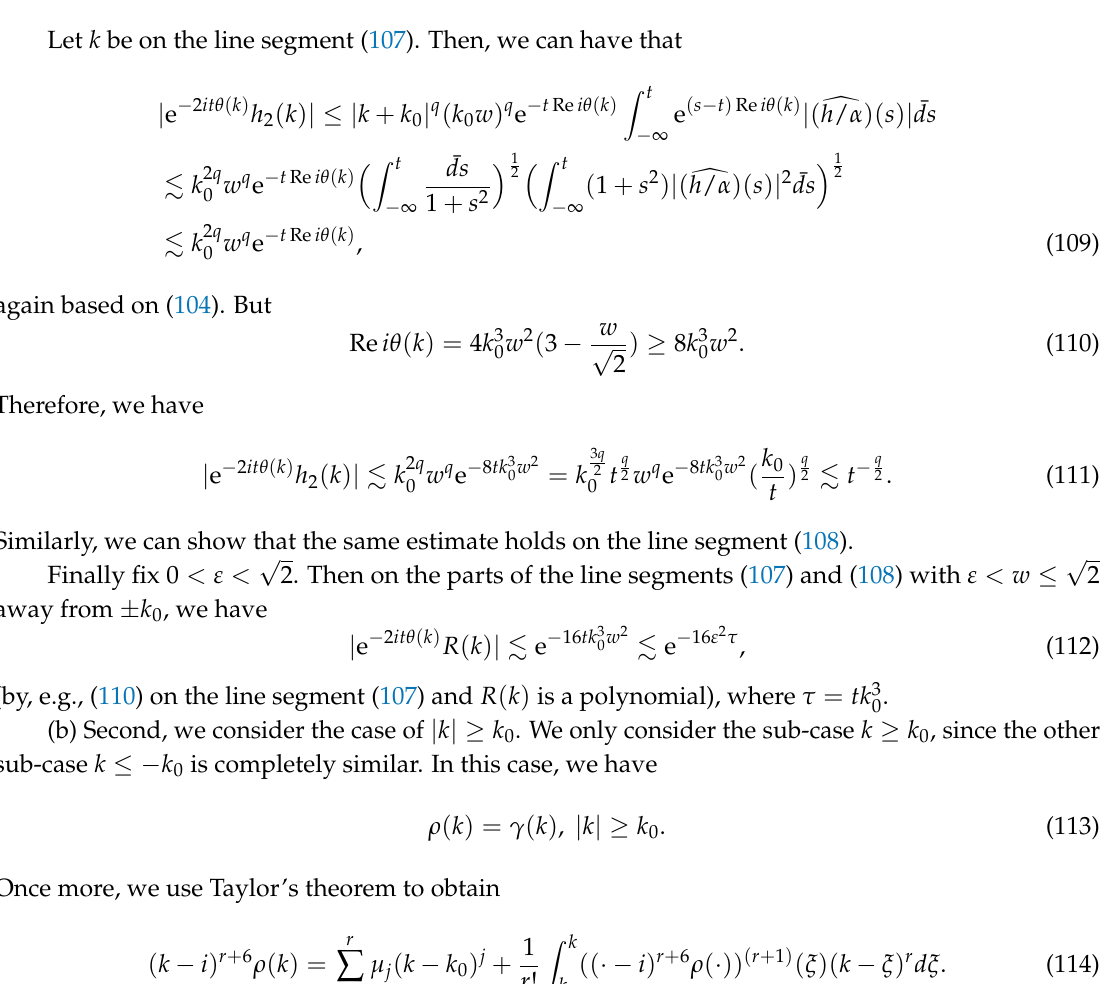
Figure 5. Part of Re i θ ( k ) > 0 in the upper half k